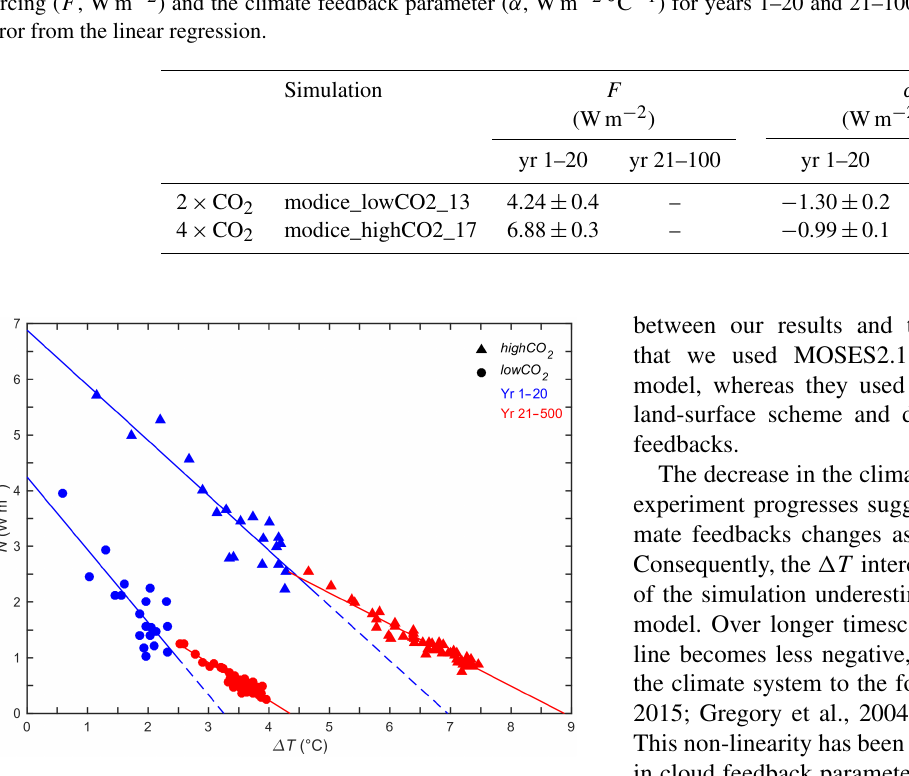
Figure 5. Gregory plot showing change in TOA net down- ward radiation flux ( N , Wm − 2 ) as a function of change in global mean annual SAT ( (cid:49)T , ◦ C) for approximate 2 × CO 2 (modice_lowCO2_13, circles) and 4 × CO 2 (modice_highCO2_17, triangles) experiments. Lines show regression fits to the global mean annual data points for years 1–20 (blue) and years 21–500 (red). Data points are mean annual data for years 1–20 (blue) and mean decadal data for years 21–500 (red). The (cid:49)T intercepts ( N = 0) of the red lines give the estimated equilibrated SAT ( (cid:49)T g eq ) for the two experiments. The (cid:49)T intercepts of the dashed blue lines represent the equilibrium that the experiment would have reached if the feedback strengths in the first 20 years had been maintained. SAT is shown as an anomaly compared with the pre-industrial con- trol